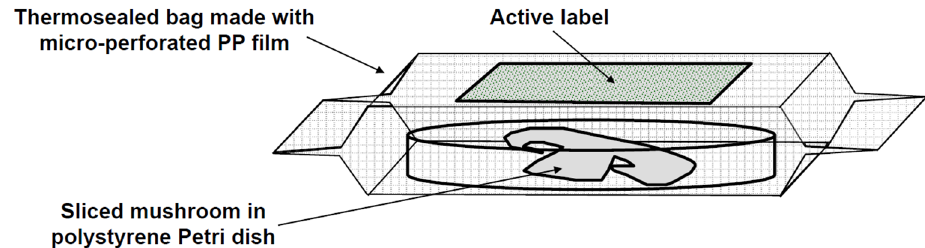
Figure 1. Structure of the active packaging used in this study.